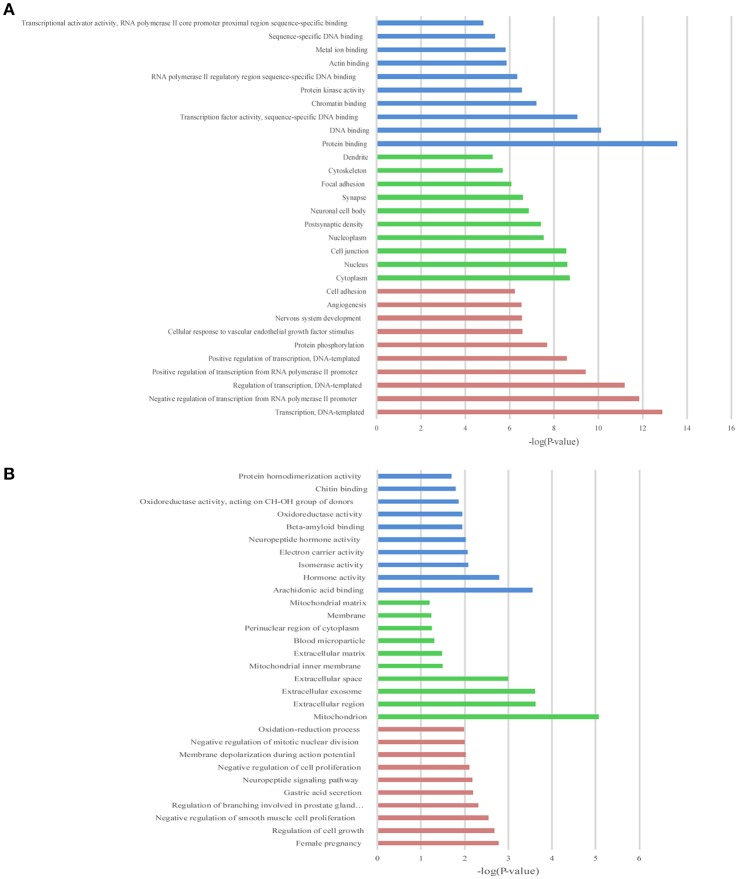
The top 10 enrichment scores in gene ontology (GO) enrichment analysis of differentially expressed mRNAs. (A) Analysis of the up-regulated mRNAs; (B) Analysis of the down-regulated mRNAs; Red bars represent biological process terms; Green bars represent cell component terms; Blue bars represent molecular function terms.